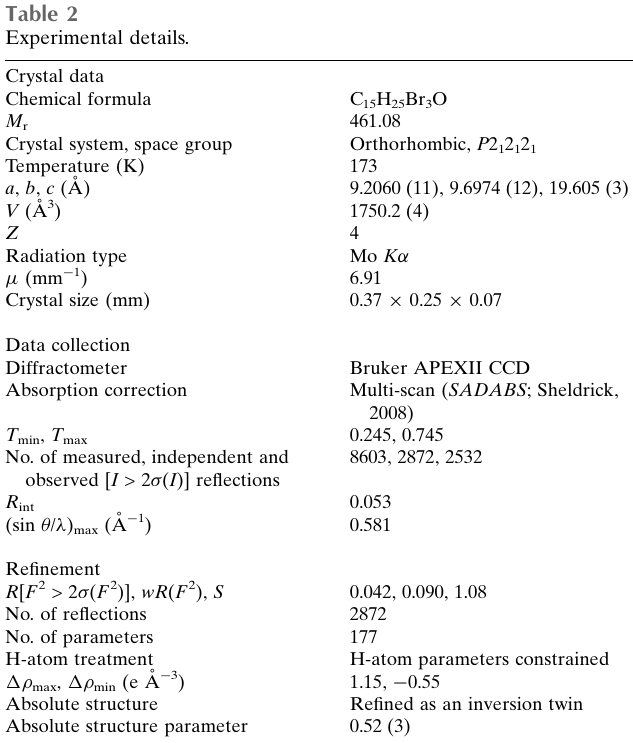
Table 2 Experimental details.